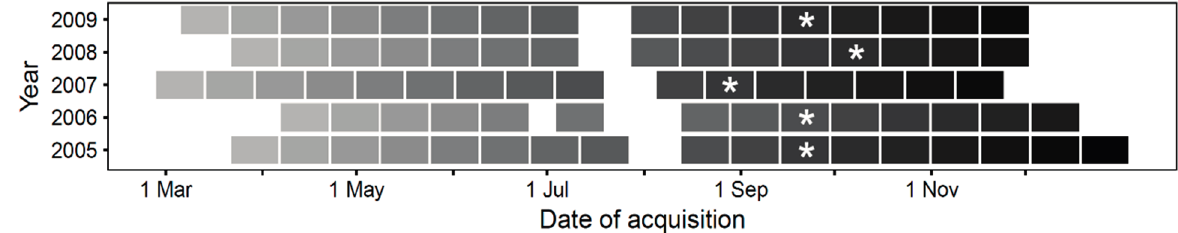
Figure 3. Acquisition dates of 16-day MODIS NBAR datasets (MCD43A4). Gaps in